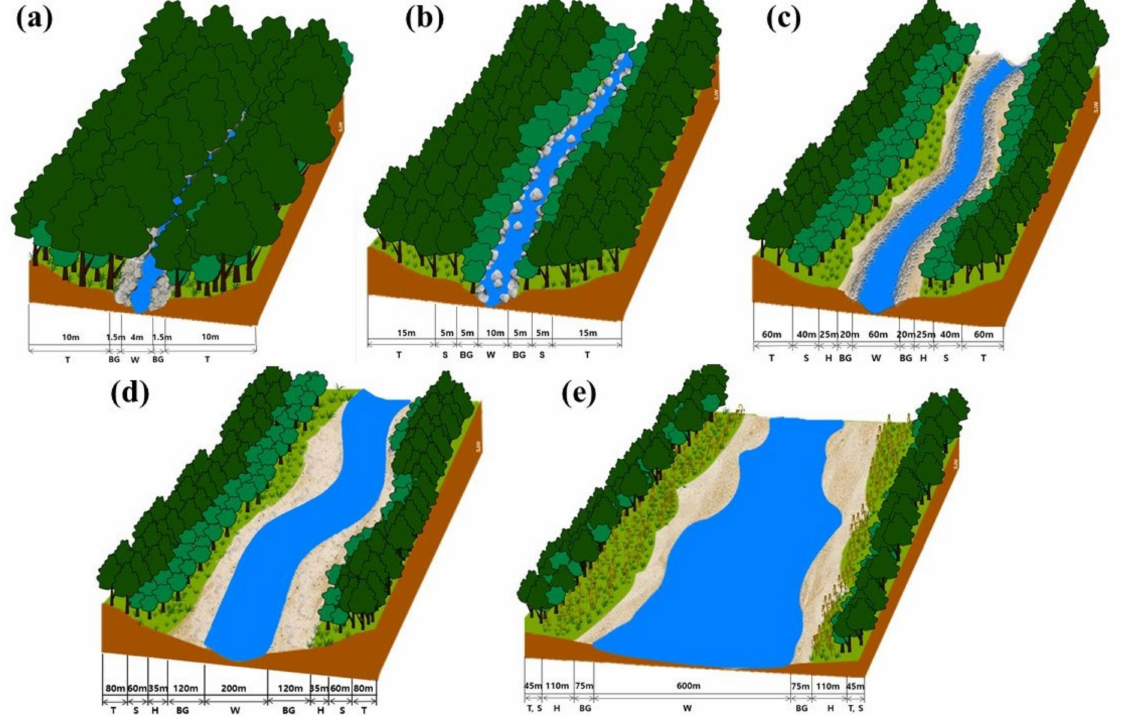
Figure 3. Spatial arrangement of riparian vegetation based on the reference information. Arrangement of landscape elements on the cross section of river appears in the order of bare ground, herb, shrub, and tree-dominated zones; zones reflecting flooding regime under the monsoon climate. Upper and lower valley streams, and downstream lack shrub and herb, herb, and shrub-dominated zones, respectively. This difference is determined by current speed due to the slope of riverbed. The breadth of each zone is a relative one and thereby it depends on the width of the waterway. Information on vegetation in each zone was suggested in Table 5. ( a ) upper valley stream, ( b ) lower valley stream, ( c ) upstream, ( d ) midstream, ( e ) downstream, W: waterway, BG: bare ground, H: herb dominated zone, S: shrub dominated zone, T: tree dominated